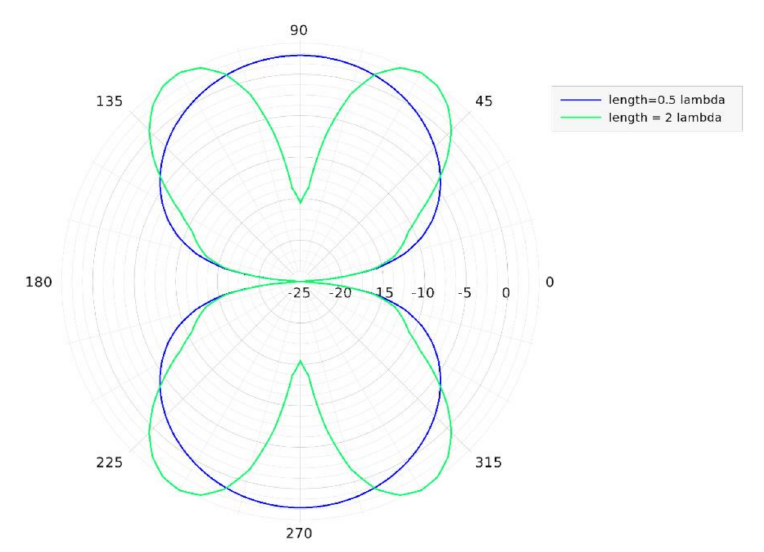
Figure 2. Gain of dipole in the plane parallel to the antenna G( θ ) —for different antenna length.